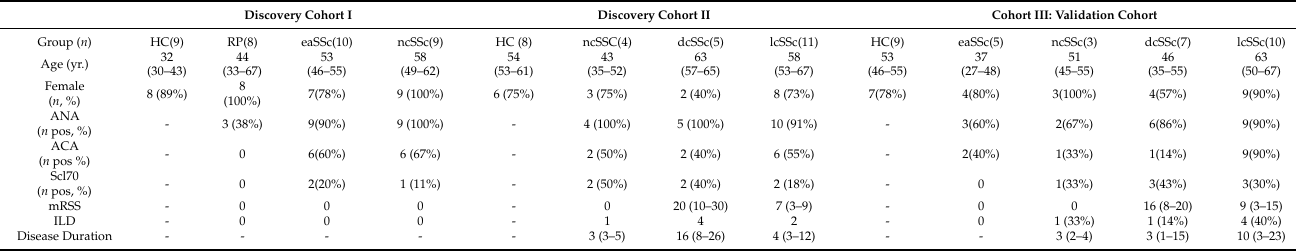
Values depict the number of patients and the median for each parameter (Interquartile Range (IQR)), if not otherwise indicated. Yr., years; ANA, antinuclear antibodies; pos, positivity; ACA, anticentromere antibodies; Scl70, antitopoisomerase antibodies; mRSS, modified Rodnan Skin score; ILD, Interstitial Lung disease; HC, healthy controls; RP, Raynaud’s Phenomenon; eaSSc, early SSc; ncSSc, non-cutaneous SSc; dcSSc, diffuse cutaneous SSc; lcSSc, limited cutaneous